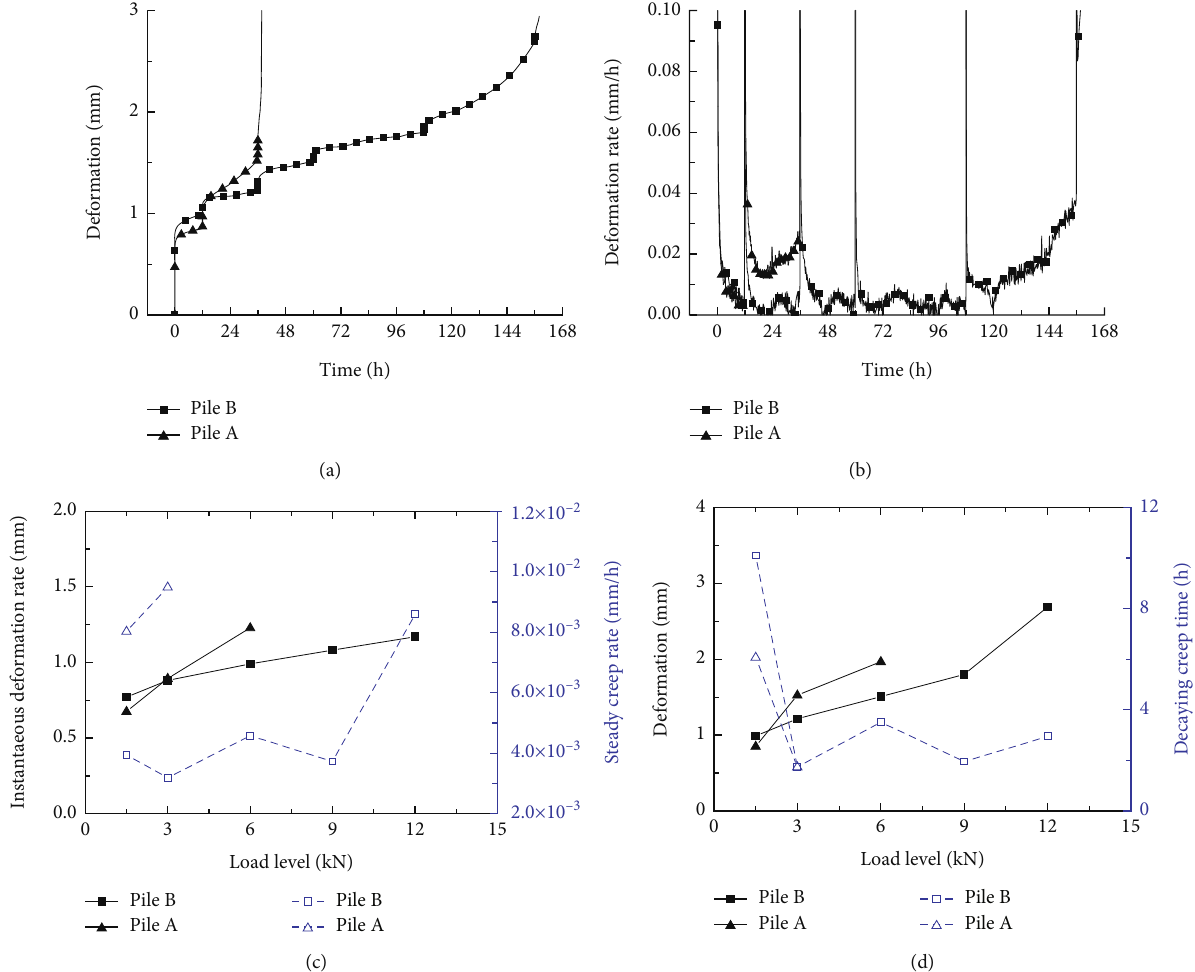
Figure 14: Creep parameters of interfaces between frozen soil and piles with di ff erent roughness.